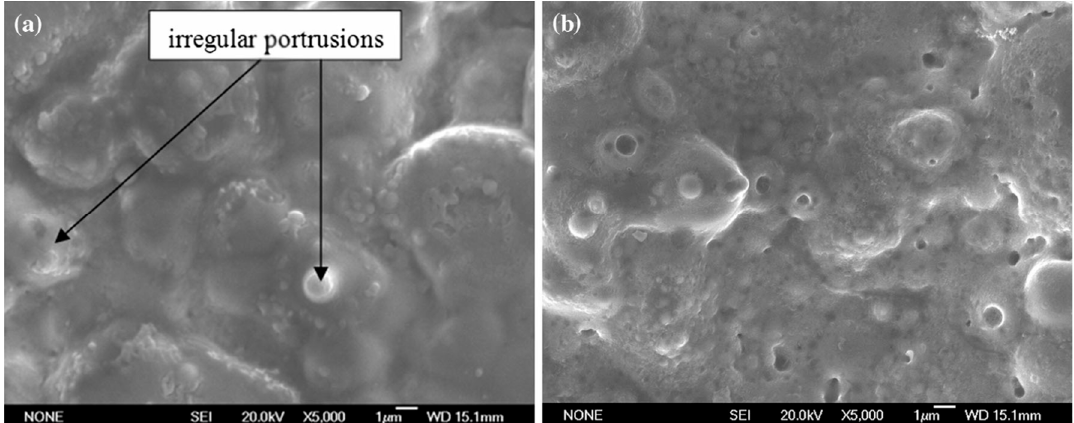
Figure 11. Microstructure of the surface of W 70 Cu 30 contacts after 1000 electrical breakdowns under vacuum conditions at: ( a ) 10 kV, ( b ) 19 kV [37].